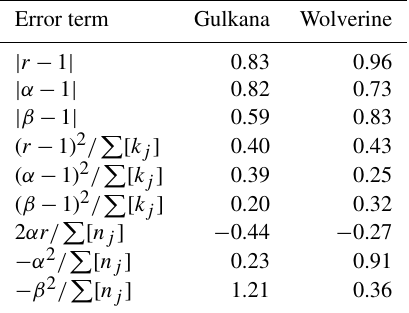
Table 4. Sources of stake measurements errors in the Kling–Gupta efficiency (Eq. 25) score in the LST-CC model during validation for Gulkana and Wolverine glaciers. The three error types are the linear correlation coefficient, r , the ratio of the model standard deviation to the observed standard deviation, α , and the bias normalized by the observed standard deviation, β . P [ k j ] and P [ n j ] refer to the sum of additive terms for the KGE score and NSE score, respectively (i.e., the denominator on the right-hand side of Eq. (29). Error term